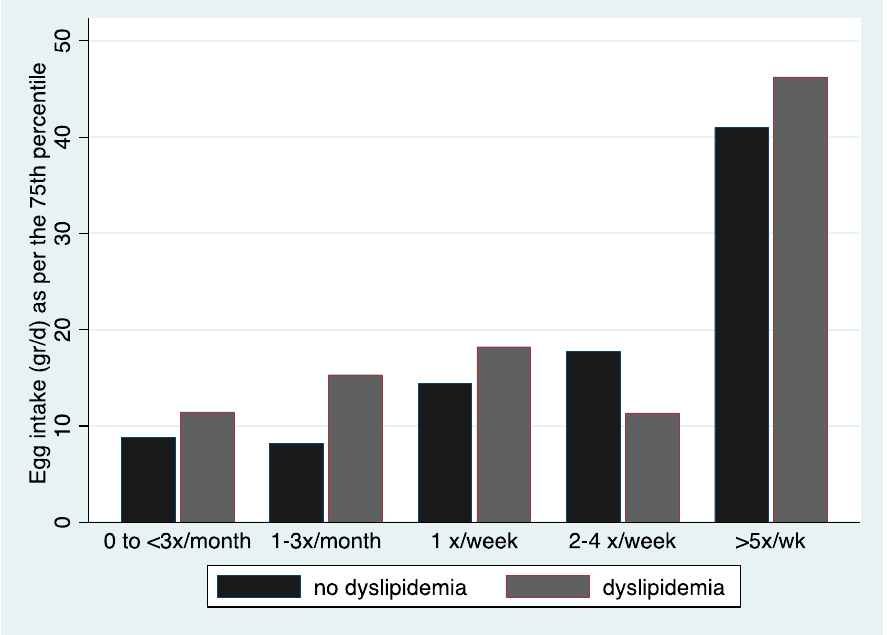
Figure 1. Egg intake (grams/day) in relation to reported frequency of intake by reported lipid status. All individuals were included. Egg intake is reported as per the 75th percentile due to skewed distribution.